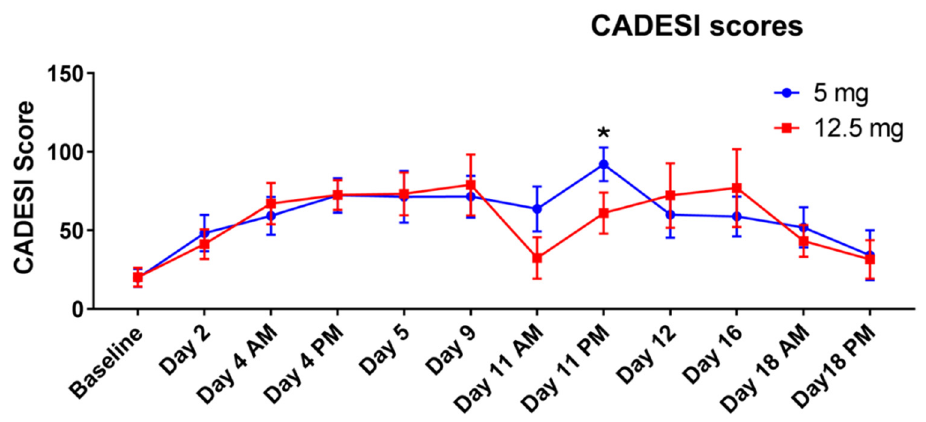
Figure 7. Clinical scores (means and standard deviation) of the dogs undergoing the low dose protocol (5 mg/dog/day, 5 days/week) and the high dose protocol (12.5 mg/dog twice weekly). On days of allergen challenge, dogs were evaluated in the morning (AM, prior to the allergen exposure) and in the afternoon, 6 h after exposure (PM). The asterisk indicates when the scores of the two protocols were different.